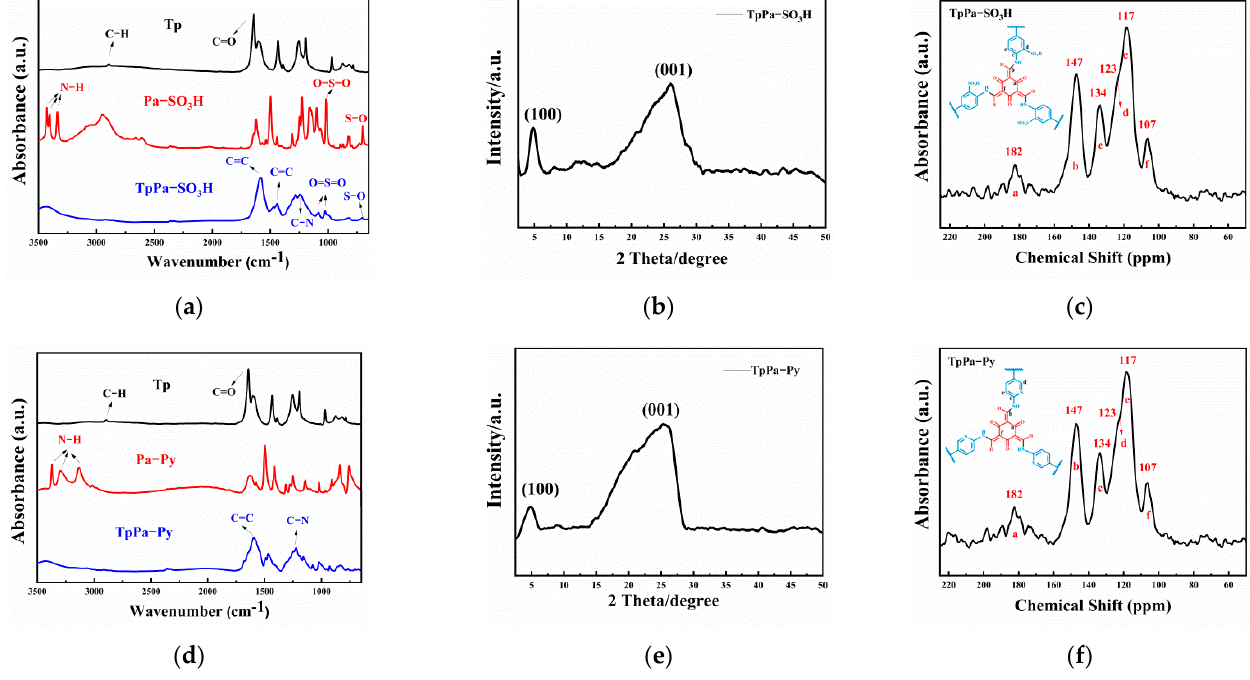
Figure 2. ( a ) FTIR, ( b ) XRD, ( c ) NMR spectra of TpPa − SO 3 H and ( d ) FTIR, ( e ) XRD, ( f ) NMR spectra of TpPa − Py. of TpPa −